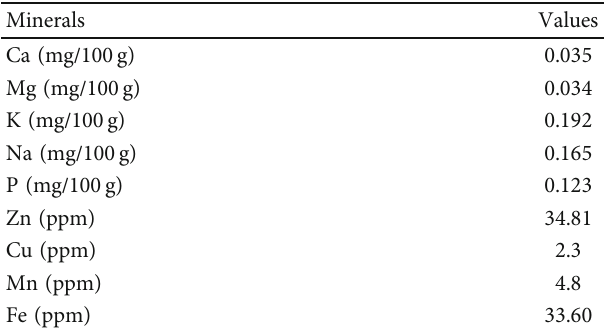
Table 7: Mineral composition of the optimized biscuit. Minerals Values Ca (mg/100 g) 0.035 Mg (mg/100 g) 0.034 K (mg/100g)